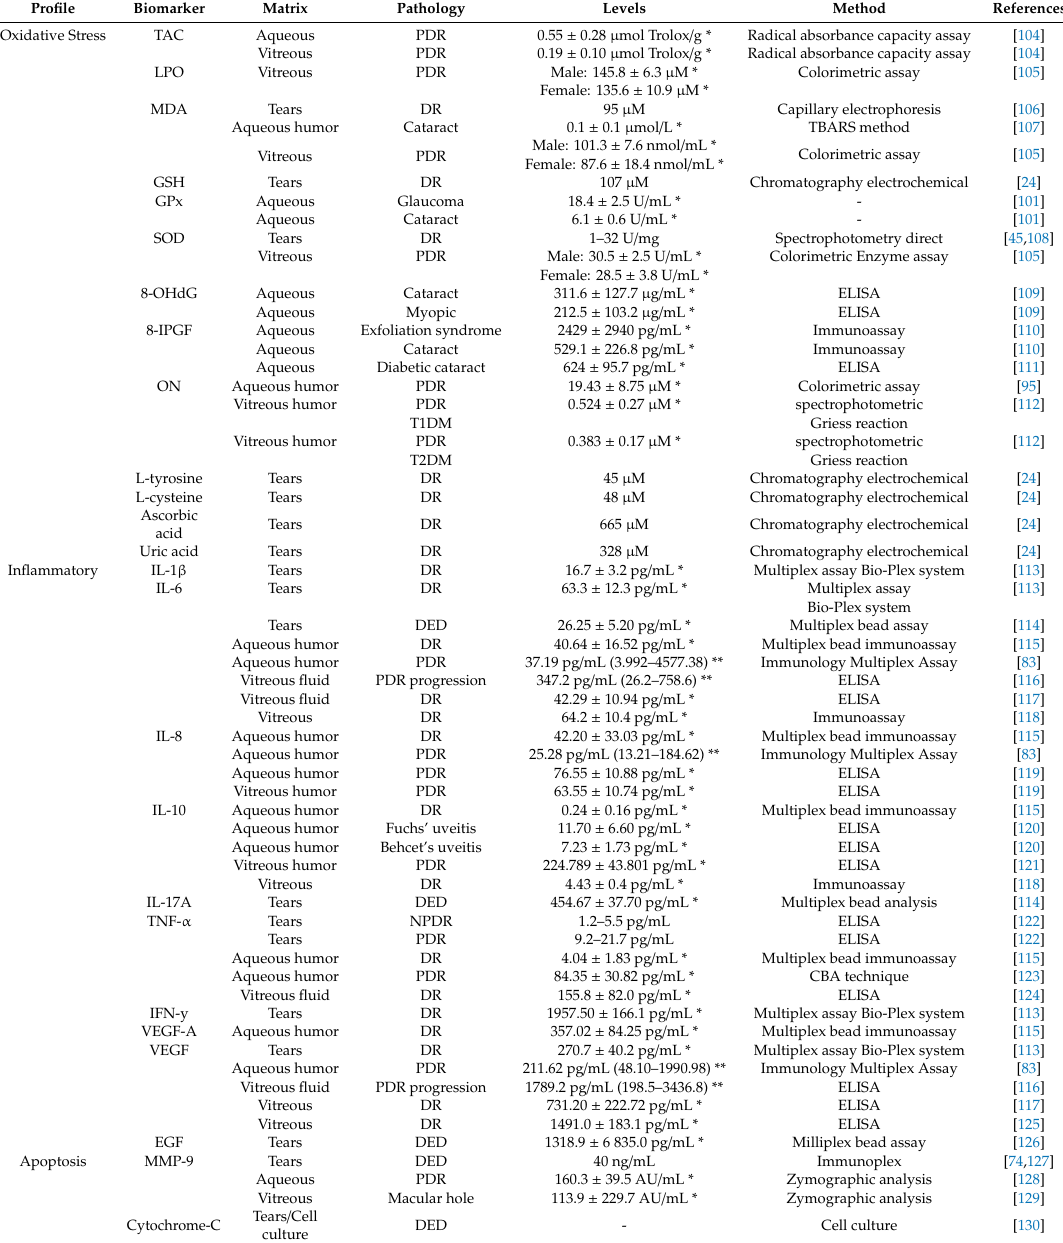
Table 1. Biomarker levels in tear, aqueous, and vitreous humor. Levels of the markers of oxidative stress, inflammation, and apoptosis measured in tear, aqueous, and vitreous humor in di ff erent ocular conditions, in addition to PDR, di ff erentiating the di ff erent methodologies used. PDR: proliferative diabetic retinopathy, DED: dry eye disease, TAC: total antioxidant capacity, LPO: